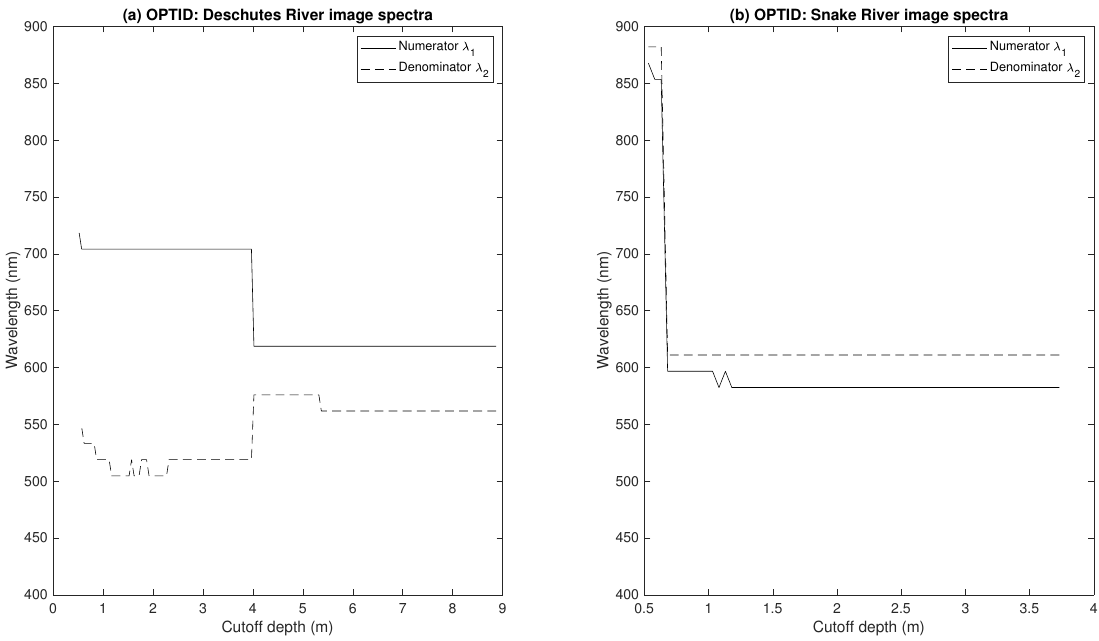
Figure 6. Summary of Optimal Band Ratio Analysis (OBRA) of Progressively Truncated Input Depths (OPTID) results for image spectra from the ( a ) Deschutes and ( b ) Snake Rivers. The numerator and denominator wavelengths identified by OBRA are plotted for each cutoff